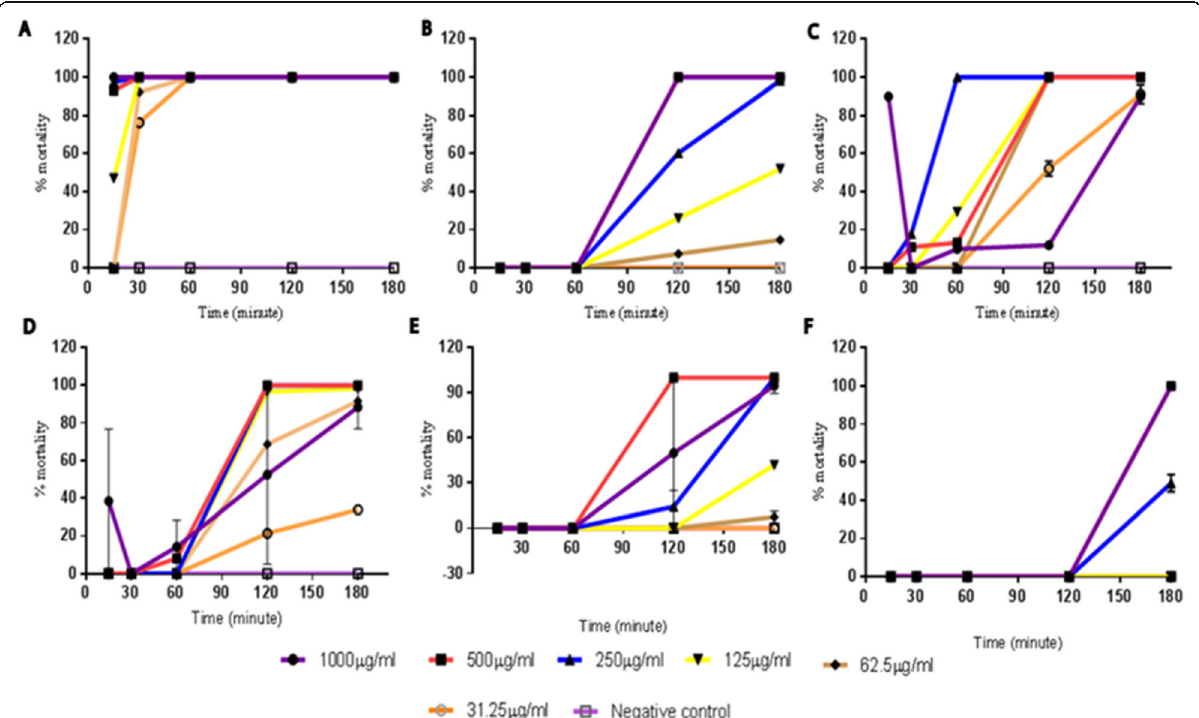
Fig. 1 Time course mortality rate of the cercariae after treatment with the plant extracts. The percent mortality rate of cercariae after 180 min. a B. aegyptica . b V. amygdalina . c A. indica . d N. latifolia . e M. lucida . f P. amarus